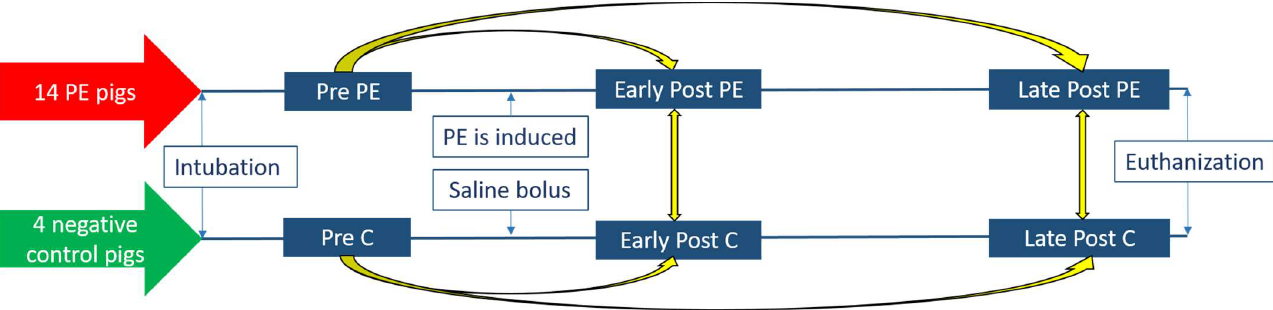
Figure 1. Timing of the collection of the exhaled breath condensate samples and overview of the comparisons (yellow). Abbreviations: PE = pulmonary embolism, C = negative control.